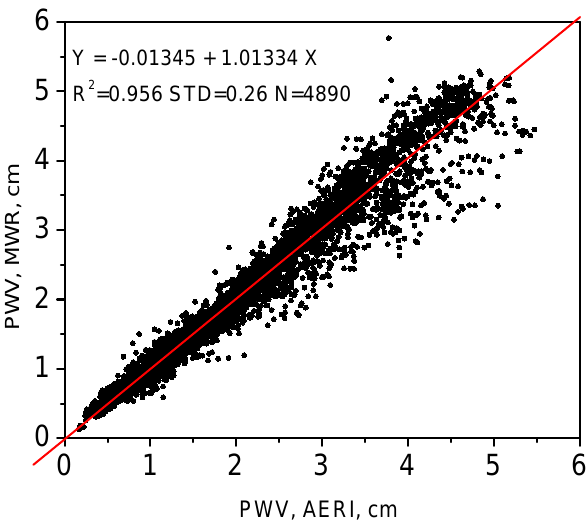
Fig. 3. Comparison of precipitable water vapor (PWV) retrieved from the AERI spectra and from MWR data during 2006. The squared correlation coefficient is 0.956.